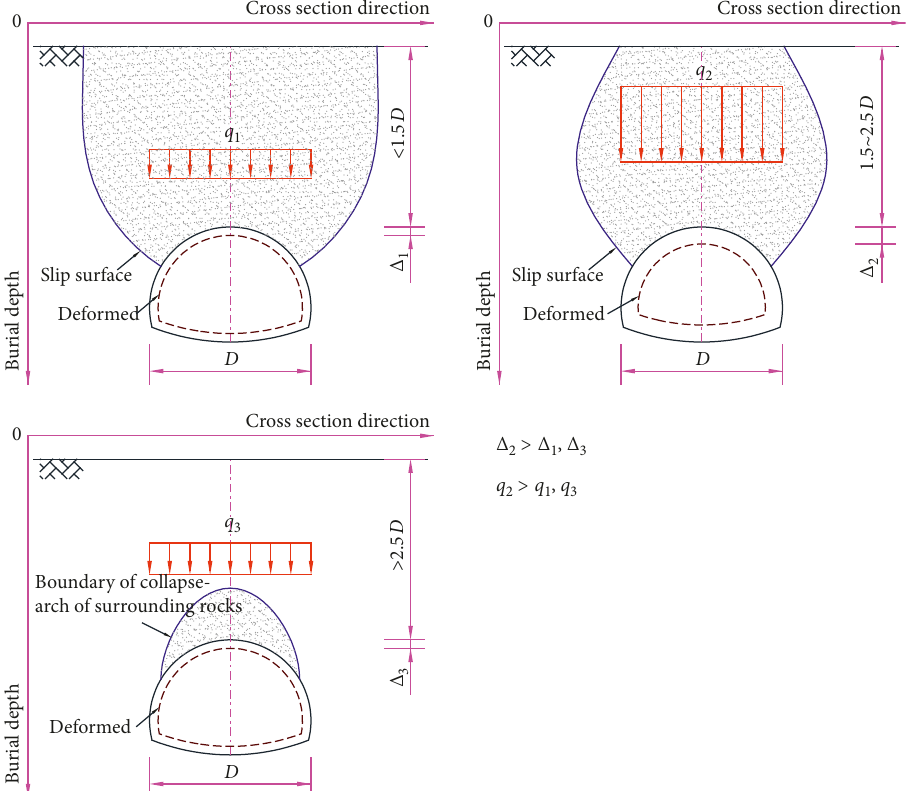
Figure 7: Schematic of weak surrounding rock deformation mechanism of the Qinggangshan tunnel